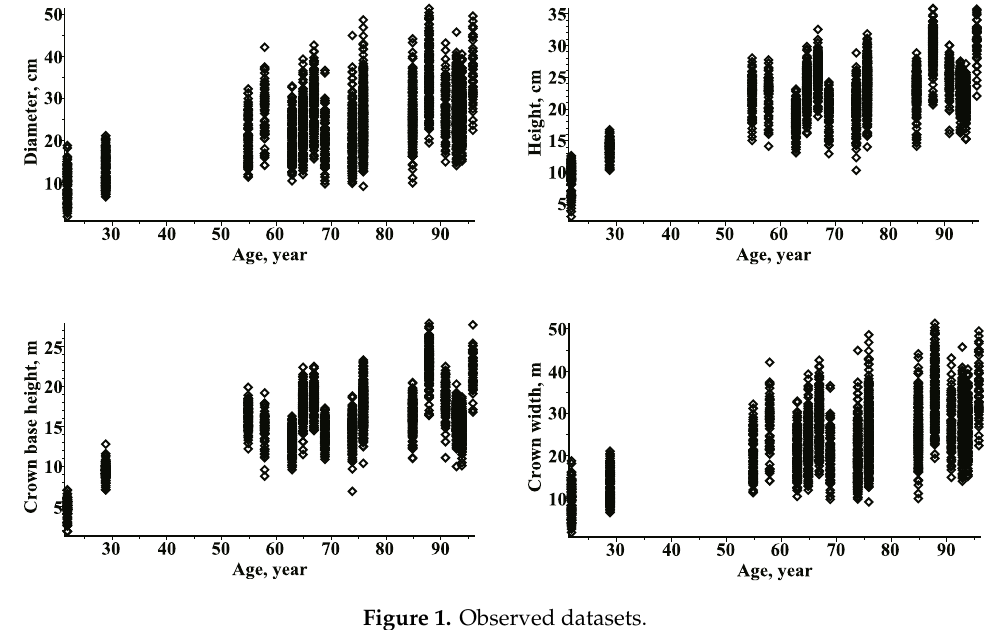
Figure 1. Observed datasets.